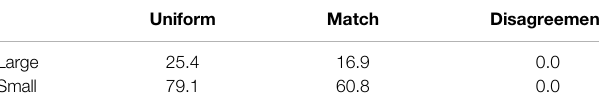
TABLE 1 | Percent of tests which did not terminate before the maximum test length( (cid:1) 1000).Shownareresultsforthetwoeffectsizesandthethreepriors. Uniform